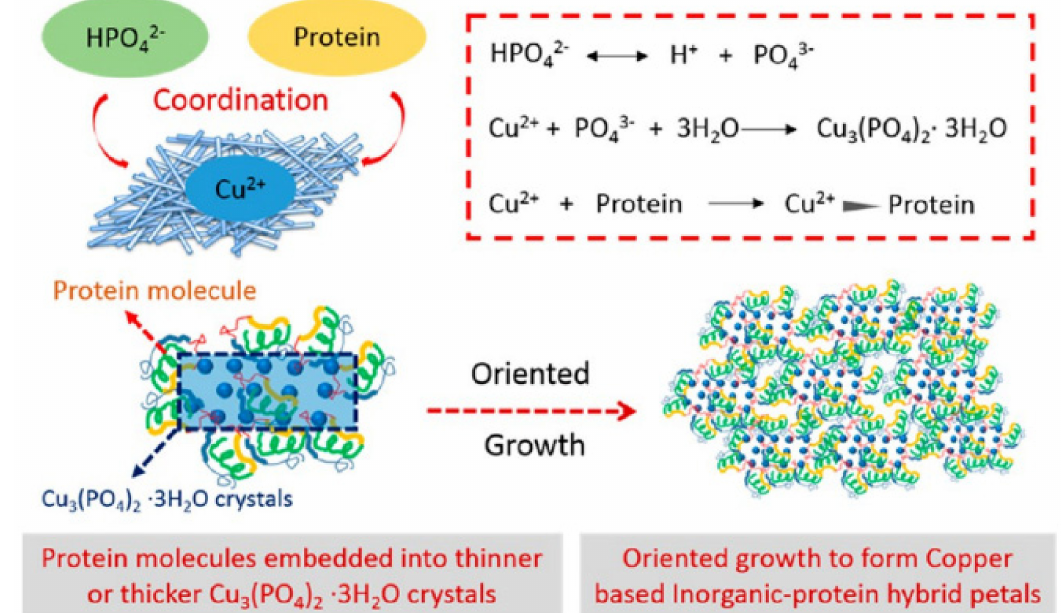
Figure 10. Formation of copper hNFs. Reprinted from [42] with permission from the American Chemical Society. Copyright © 2021 American Chemical